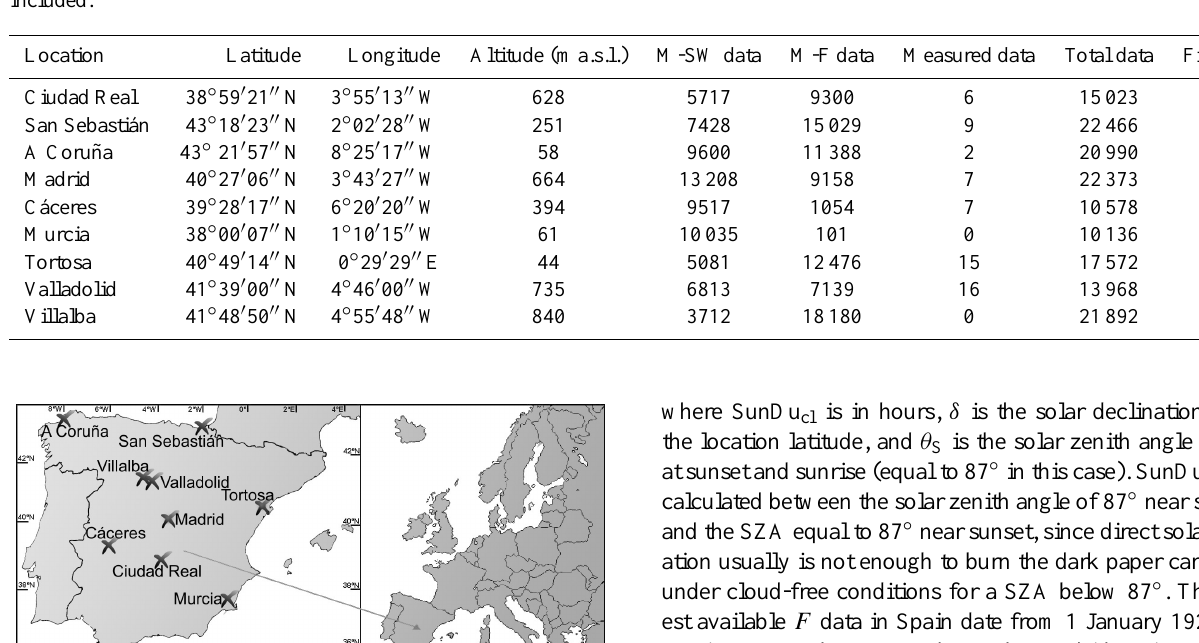
Table 1. Coordinates of the AEMet stations used, and number of data of the final reconstructed series which were filled with the M-SW model, the M-F model or with measurements. The total number of data of each final reconstructed series and the year when it began are included.